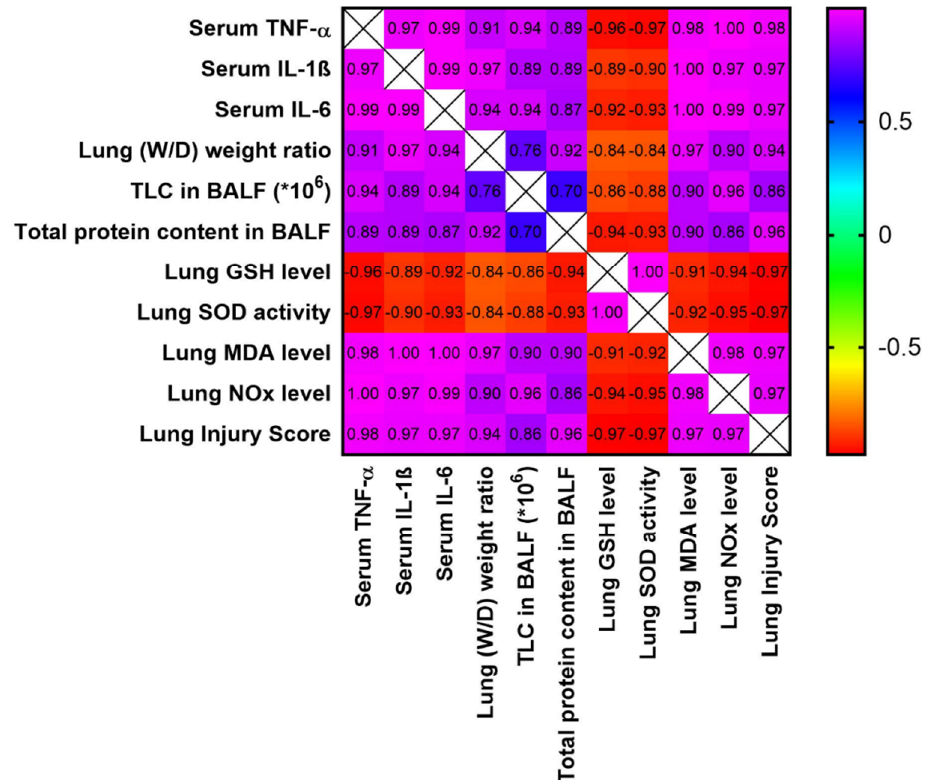
Figure 6. Correlation matrix for different parameters included in the study and the lung injury scores. The correlation coefficient used for analysis is the Pearson correlation coefficient (r). Positive values of r indicate positive correlation, while negative values indicate negative correlation. The correlation was considered strong if the value of r was between |0.6| to |0.79|, while the correlation was considered very strong if r > |0.79|. The range of the colors of the scale on the right, from violet to red, refers to r values from +1 to −1. IL-1β: interleukin-1b; IL-6: interleukin-6; TNF-α: tumor necrosis factor-α; BALF: bronchoalveolar lavage; TLC: total leukocytic count; (W/D): wet/dry.